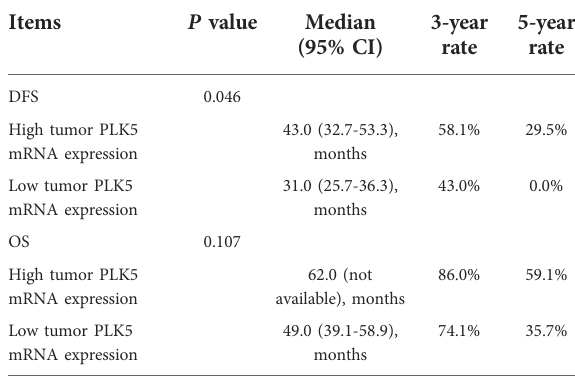
TABLE 6 Correlation of tumor PLK5 mRNA expression with DFS and